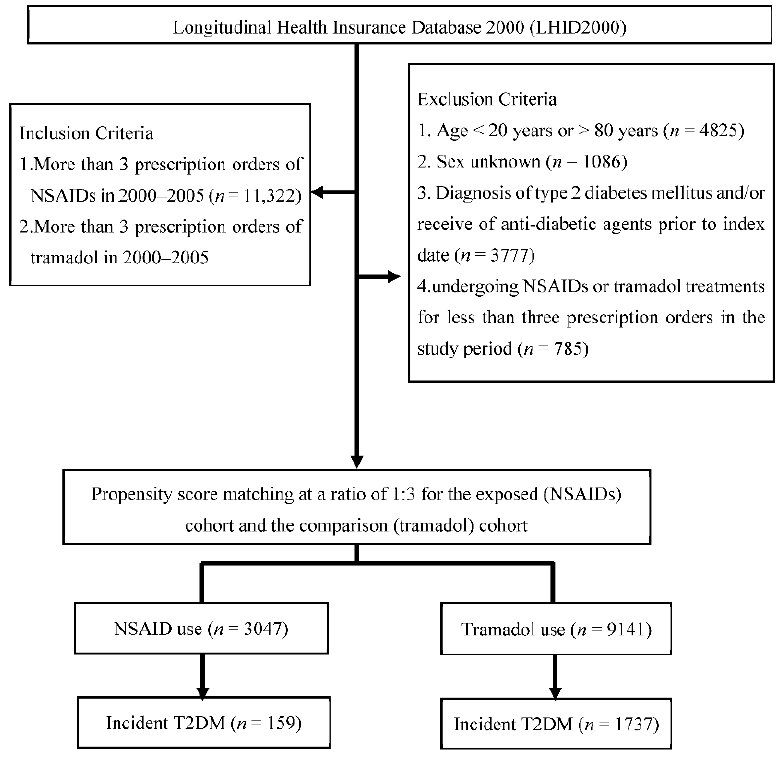
Figure 1. Flow chart of the study design. T2DM, type 2 diabetes mellitus; NSAIDs, non-steroidal anti-inflammatory drugs.